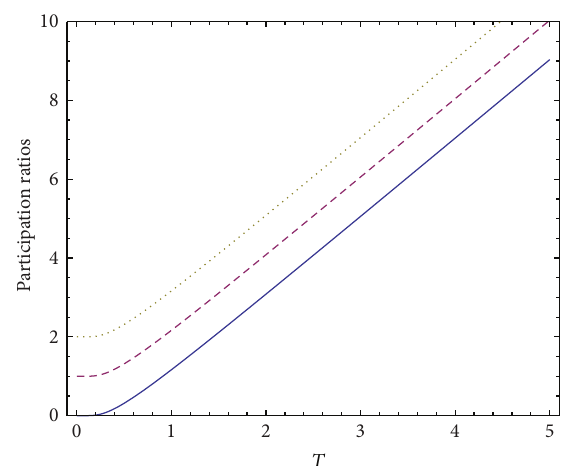
Figure 6: Participation ratio 𝑚 versus temperature 𝑇 in (ℏ𝜔/𝑘 𝐵 ) - units. The solid line is the case 𝑃 , the dashed one is the Wigner one, and the dotted curve is assigned to the Husimi